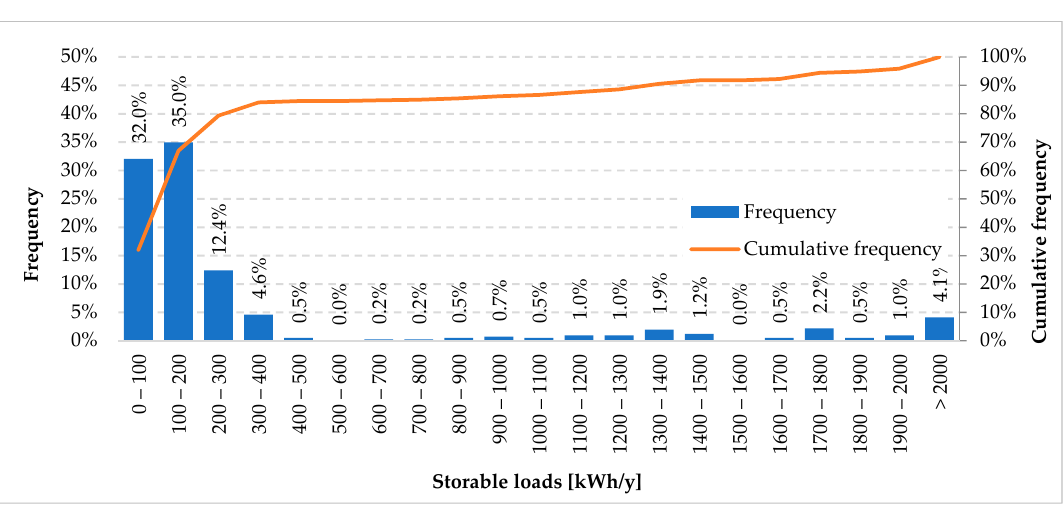
Figure 10. Storable loads.